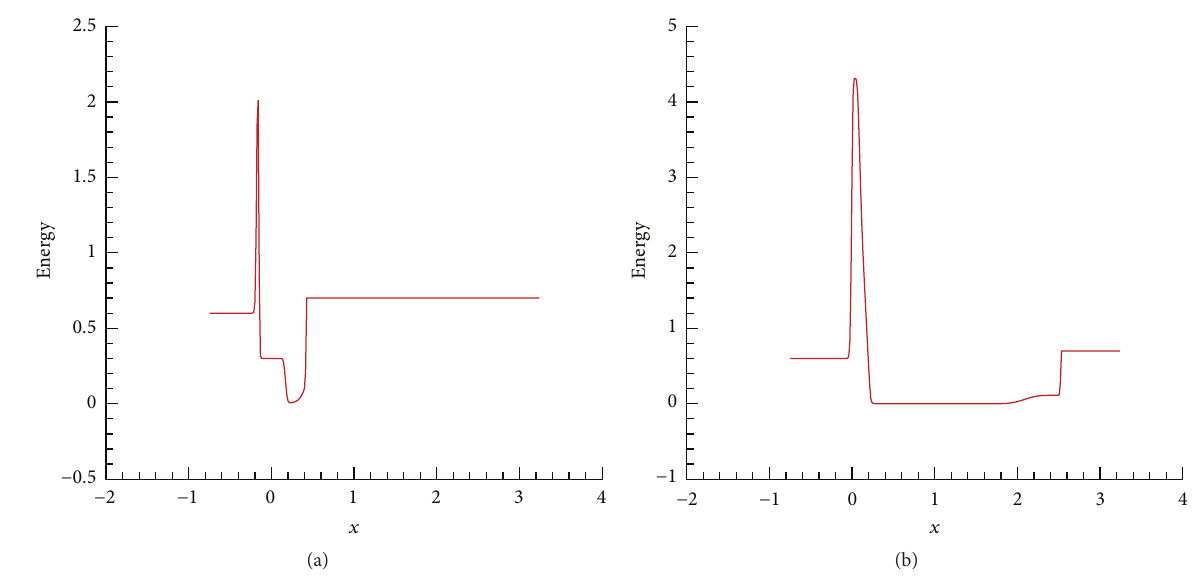
Figure 13: Numerical results of 𝐻 at 𝑡 = 0.5 (a) and 𝑡 = 5.5 (b) for Data 3.